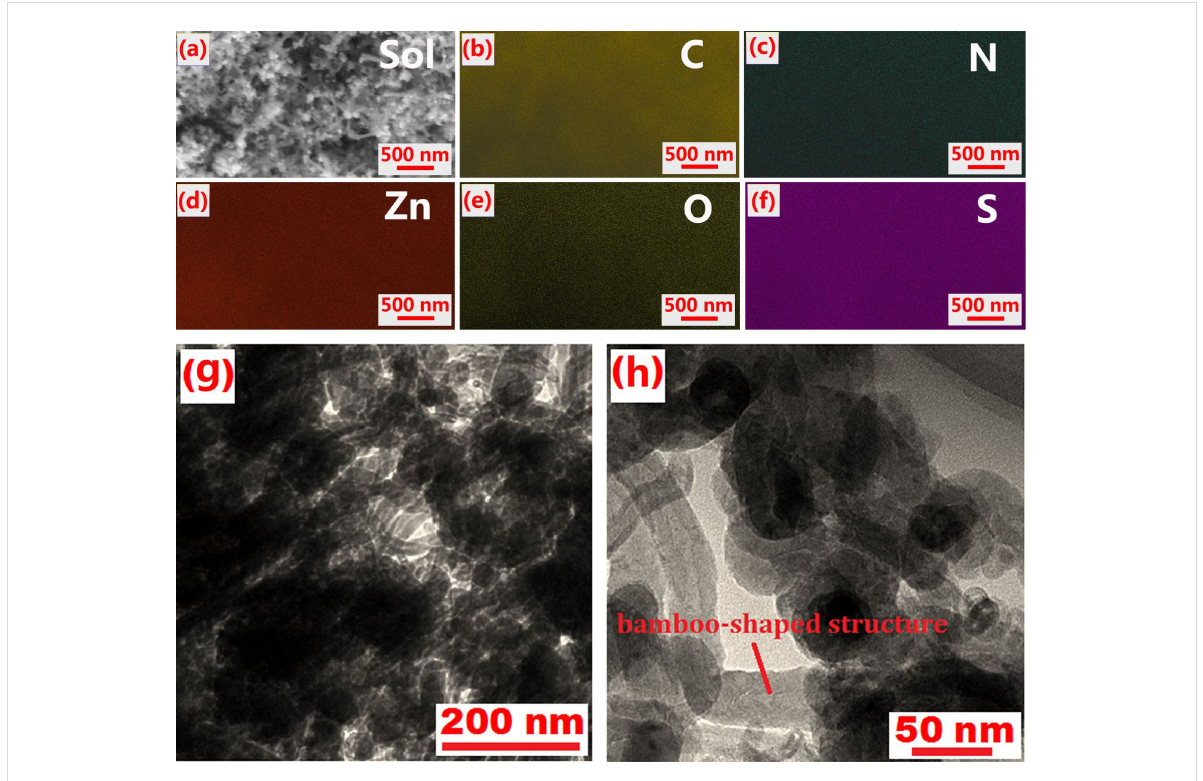
Figure 4: (a) SEM image; (b–f) EDX mapping; (g,h) TEM images of S/ZnO@NCNT